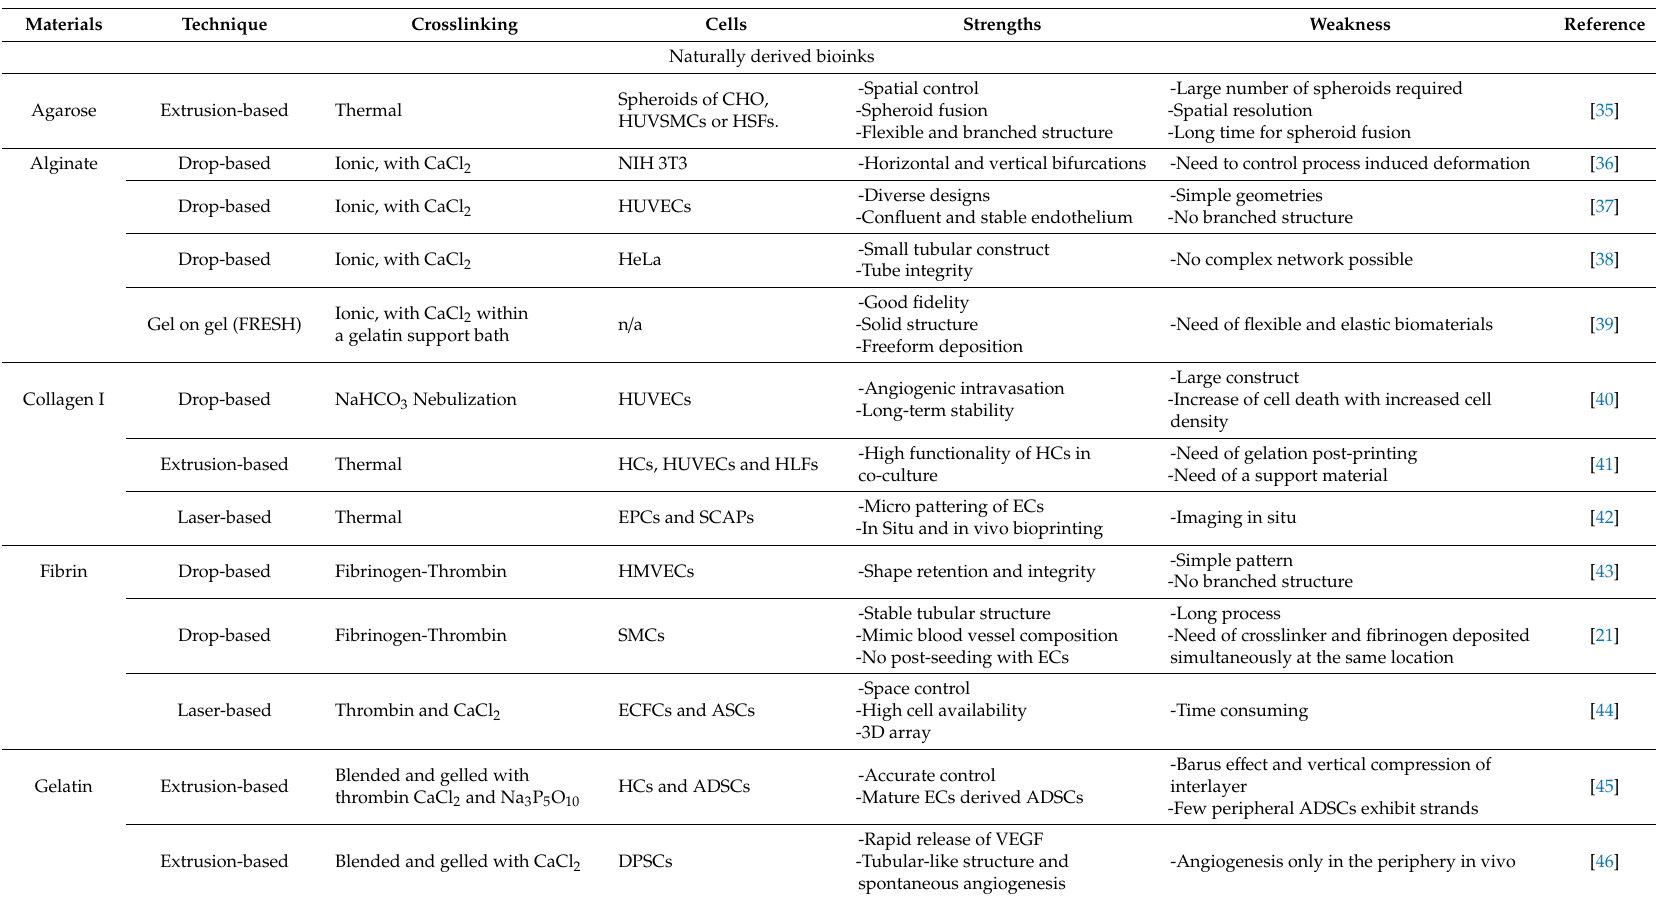
Table 1. Summary of materials used in vascular bioprinting, techniques, cells and strengths and weaknesses of these